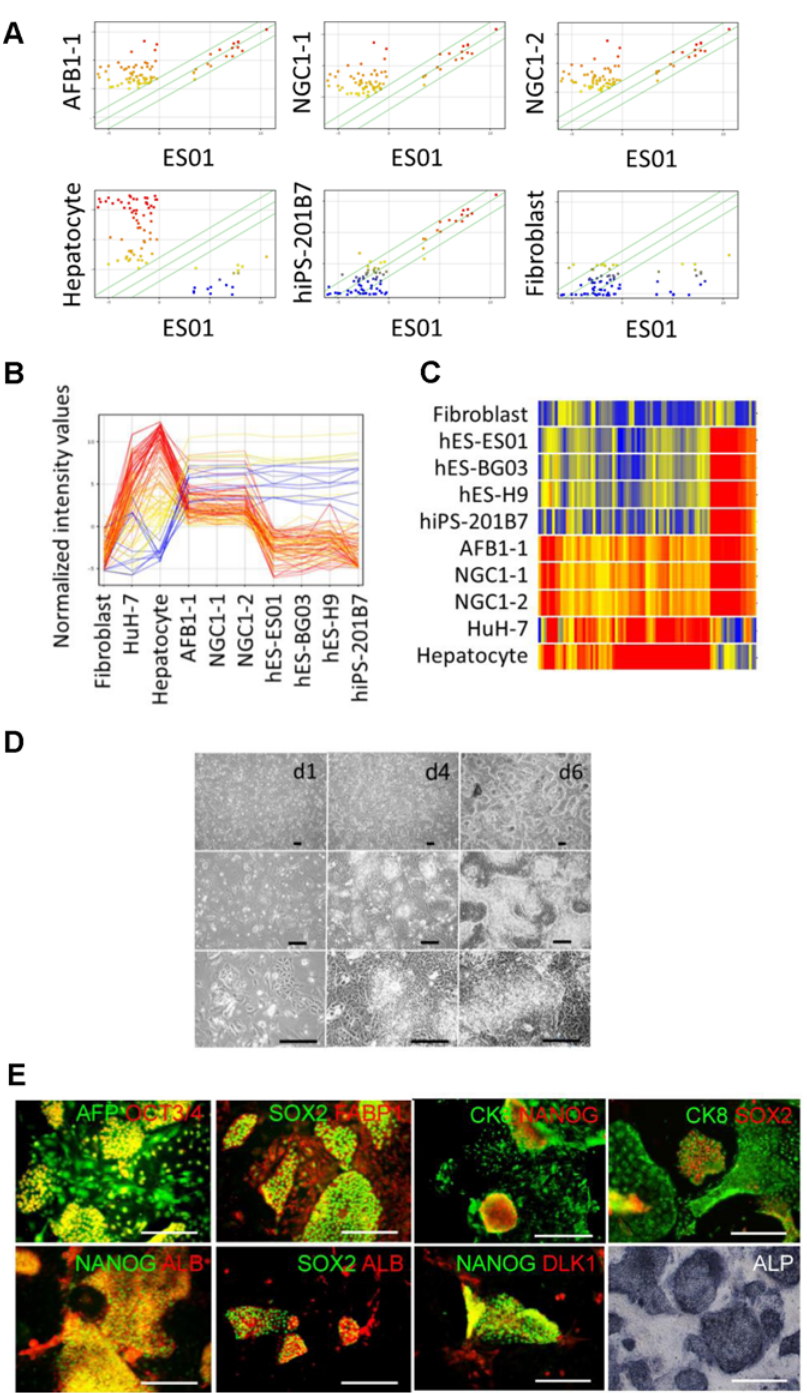
Fig 1. Established hiHSCs express markers of both ESCs and hepatocytes. ( A, B, C ) The gene expression of established hiHSCs was analyzed by DNA microarray. Shown are data characterized by ( A ) scatter plots, ( B ) profiling plots, and ( C ) a heat map of the expression profiles of embryonic stem cell (ESC)- and hepatocyte-enriched genes to compare hiHSCs (clones AFB1-1, NGC1-1, and NGC1-2) with fibroblasts, human ESCs (ES01, BG03, and H9), hiPSCs (201B7), a hepatocellular carcinoma cell line (HuH- 7), and human adult hepatocytes. Normalized fluorescent intensity values range from red (high) to blue (low) coloring. Scatter plots are colored by the values of cell samples along the Y-axis. Profiling plots are colored by the values of hepatocytes. All three of the clones exhibit unique gene expression profiles expressing